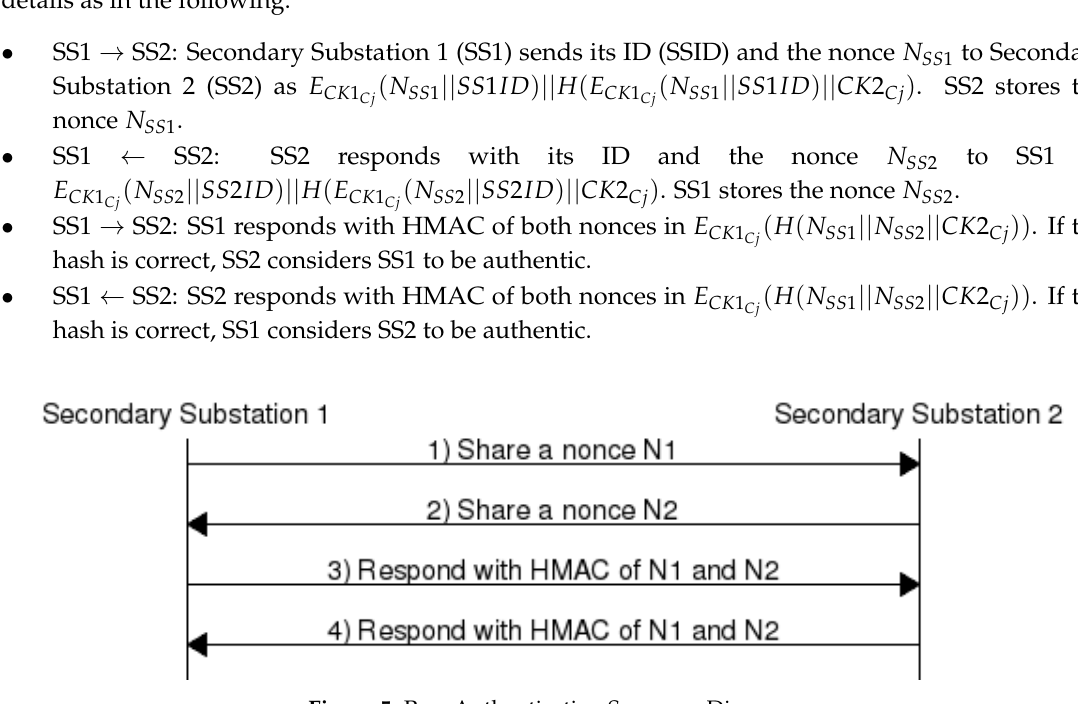
Figure 5. Peer Authentication Sequence